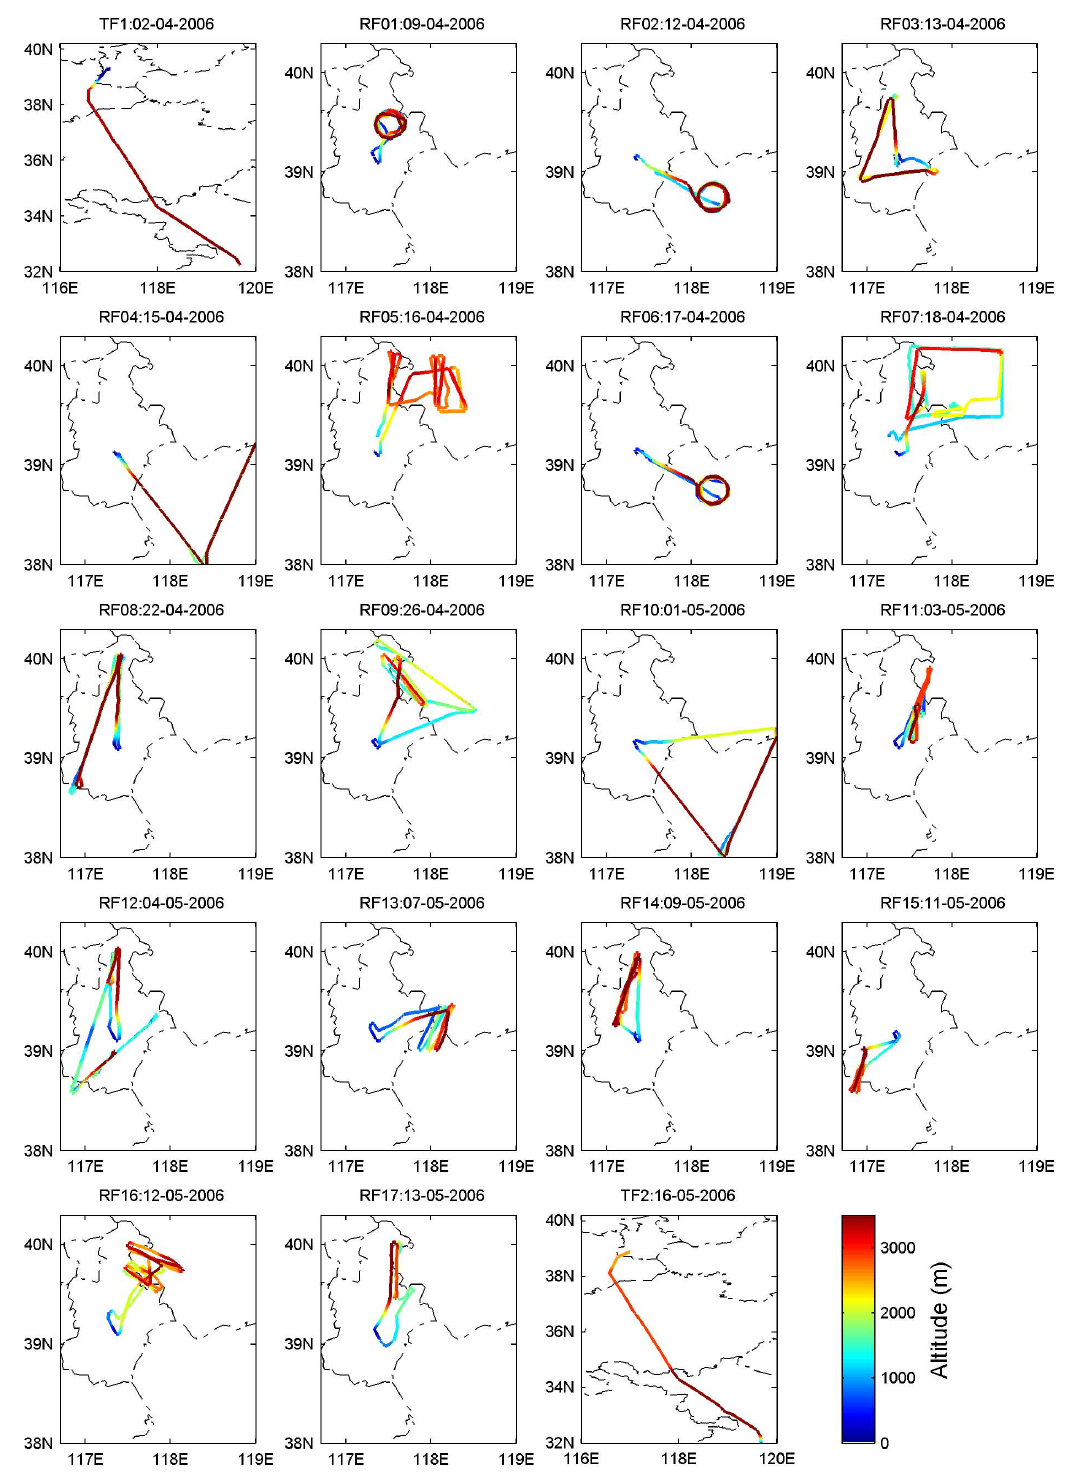
Fig. 5. YUN-12 individual flight tracks during IPAC-NC colored by altitude. Two transfer flights and 17 research flights were performed from 2 April to 16 May